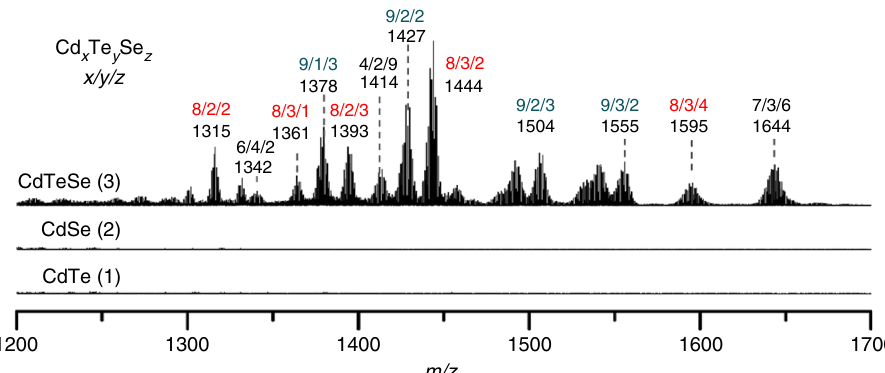
Fig. 3 ESI-MS spectra of two binary samples and their mixture. Both the binary CdTe (trace 1) and CdSe (trace 2) samples were heated at 120 °C for 30 min; they were mixed at room temperature with equal volumes; the resulting mixture (trace 3) was incubated for 30 min. The Cd x Te y Se z fragments (trace 3) suggest the formation of Te – Cd-Se covalent bonds in the mixture, which is in agreement with the substitution reactions described by Equations (2) and (3)